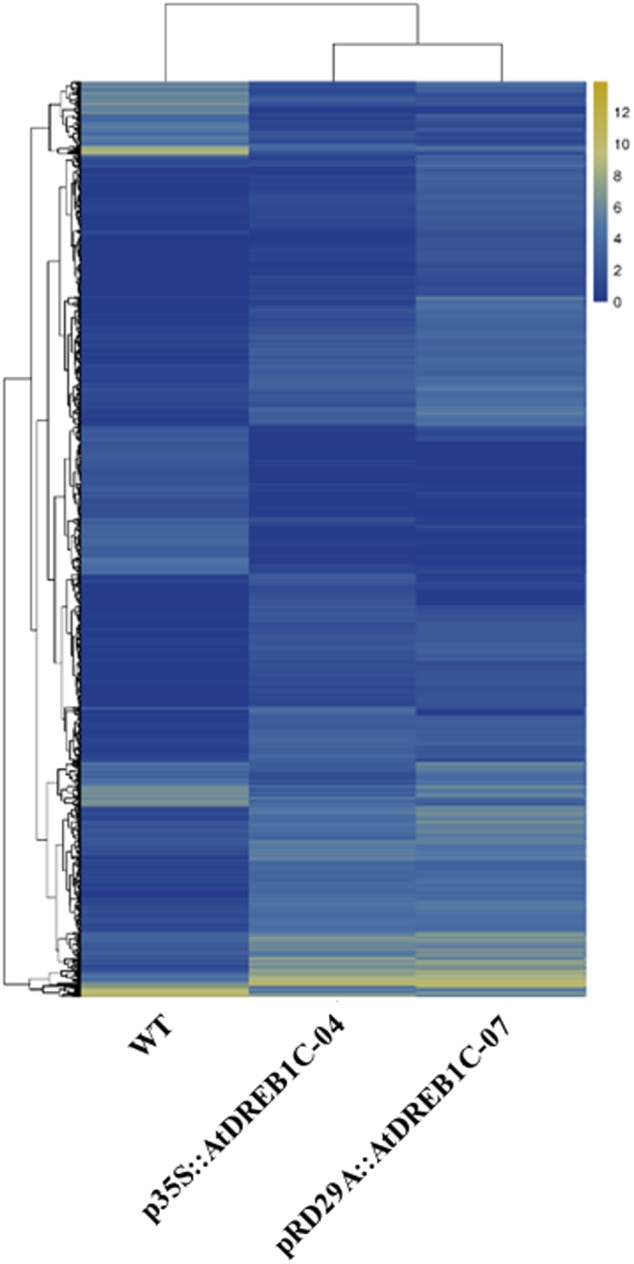
Clustering analysis of DEGs in WT and AtDREB1C transgenic S. miltiorrhiza plants based on their expression profiles obtained by RNA-Seq. WT, wild type; p35S::AtDREB1C-04, p35S::AtDREB1C transgenic line 04; pRD29A::AtDREB1C-07, pRD29A::AtDREB1C transgenic line 07. The color scale corresponds to the log2 (FPKM) values of genes in various samples.